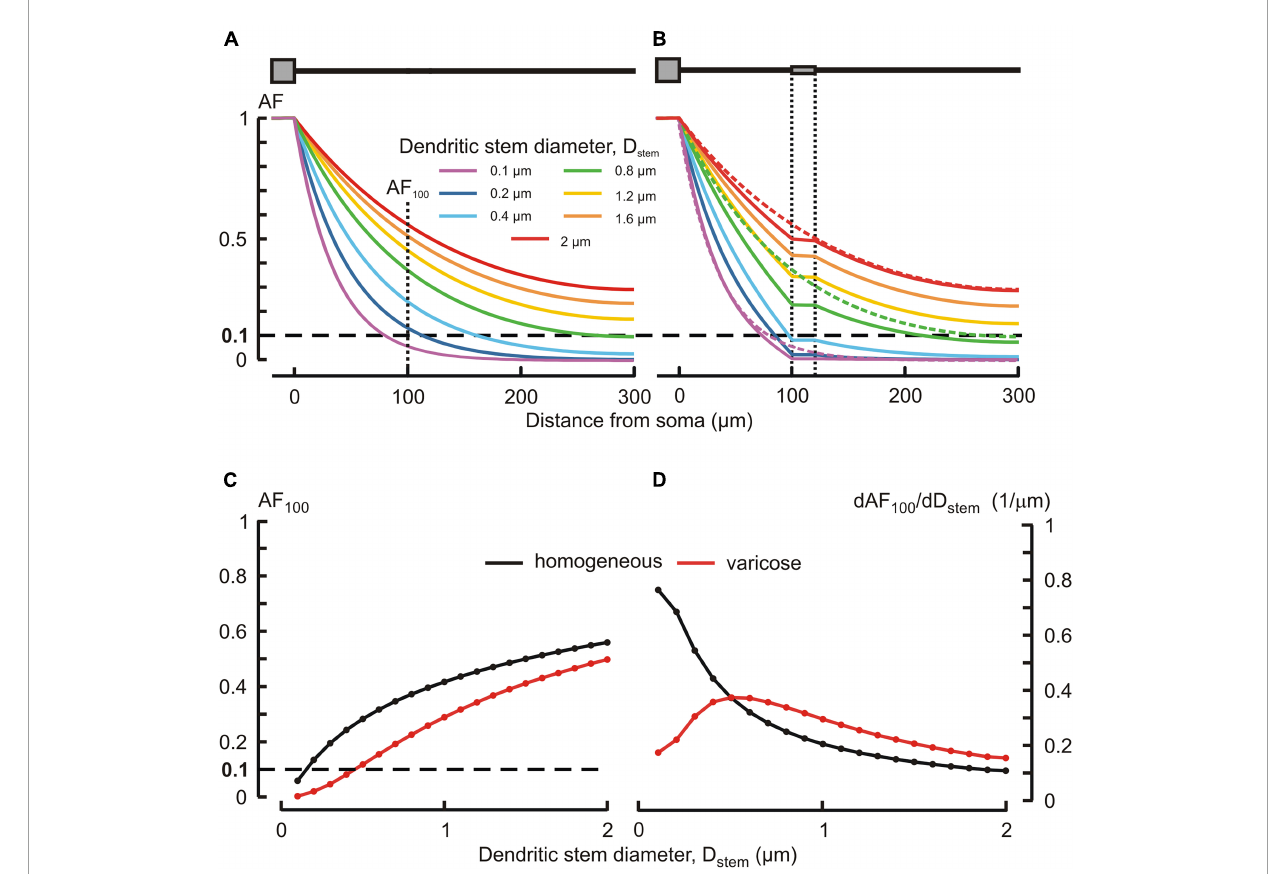
FIGURE2 Effects of the dendritic stem diameter and presence of varicosity on the voltage attenuation along the dendrite. (A,B) Attenuation factor AF(x) (ordinate, dimensionless) as a function of the path distance from soma x (abscissa, µ m) for different dendritic stem diameters D stem (color-coded) in, respectively, the absence and presence of a varicosity of 20 µ m length and µ m diameter. Dotted lines in (B) represent plots of corresponding color in (A) . (C) Attenuation factor at 100 µ m from soma AF 100 (ordinate, dimensionless) as a function of the dendrite stem diameter d 1 = d 3 = D stem (abscissa, µ m). (D) Sensitivity function of the attenuation factor dAF 100 /dD stem (ordinate, 1/ µ m) to changes in the D stem (abscissa, µ m) of homogeneous (black) and varicose (red)